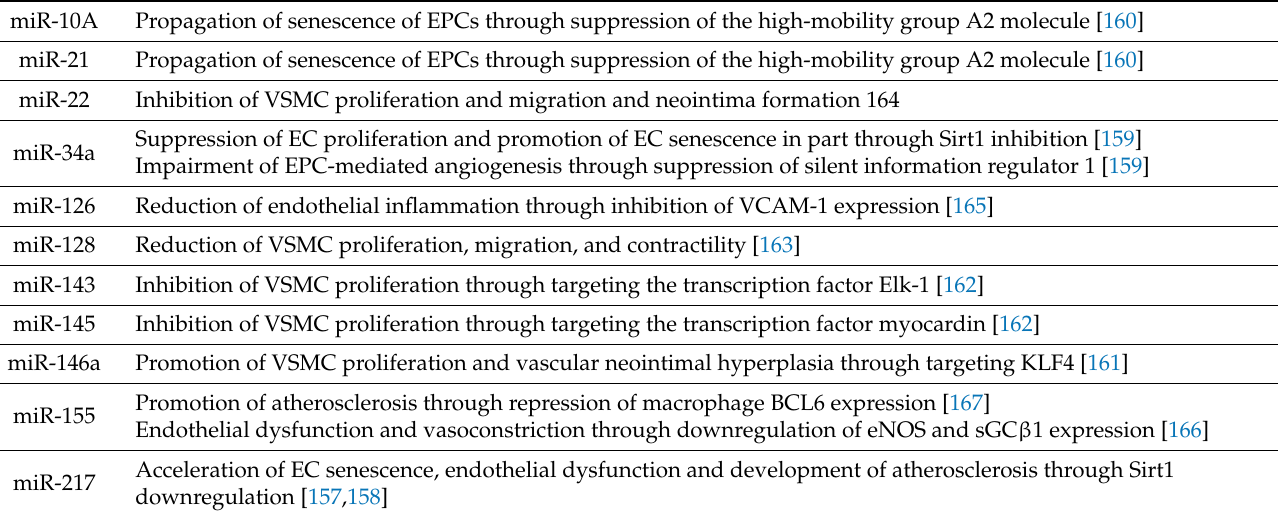
Table 3. Major miRNAs and their involvement in vascular